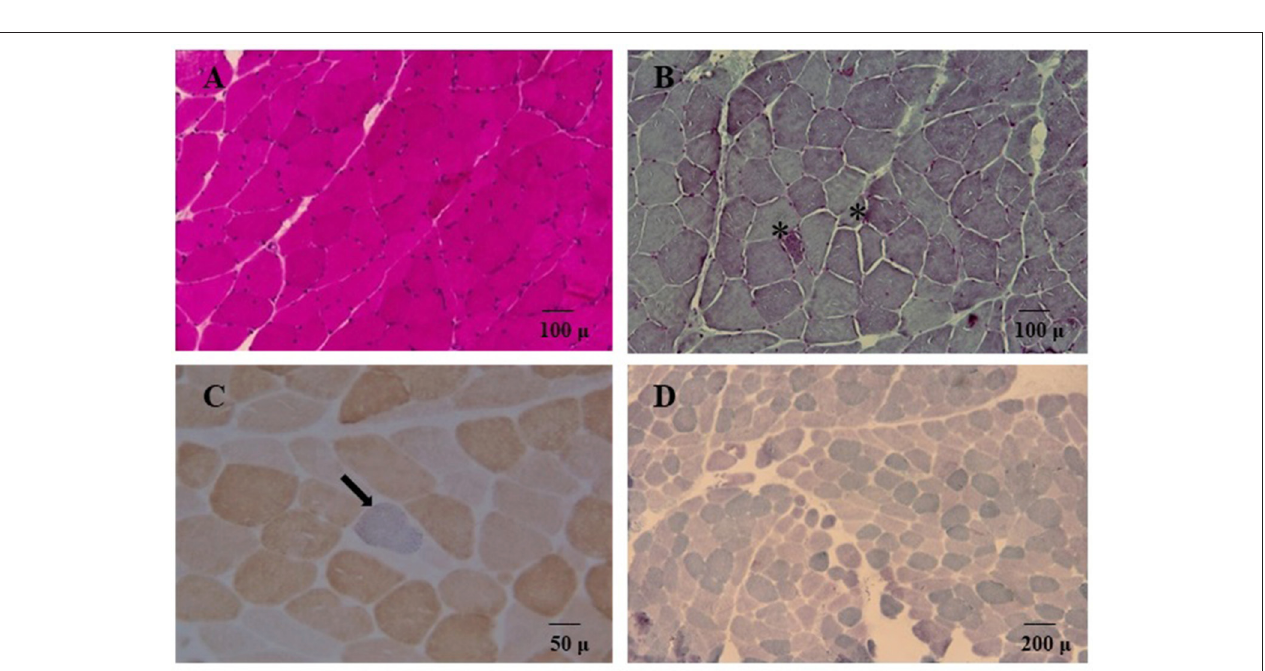
FIGURE 3 | Hematoxylin and eosin stain (A) and Gömöri trichrome stain (B , 20X) showed variability of muscle morphology with some atrophic fibers. In (B) asterisks denote some ragged-red fibers. Double cytochrome c-oxidase/succinate dehydrogenase (COX/SDH) stain (40X) is depicted in panel (C) ; a single COX-deficient blue fiber is indicated (arrow). In (D) SDH staining (10X) showed globally reduced activity.